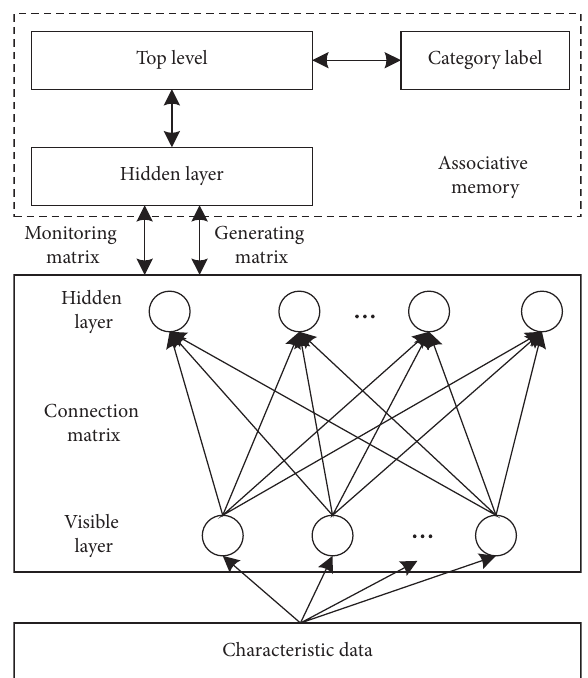
Figure 2: DBN model structure